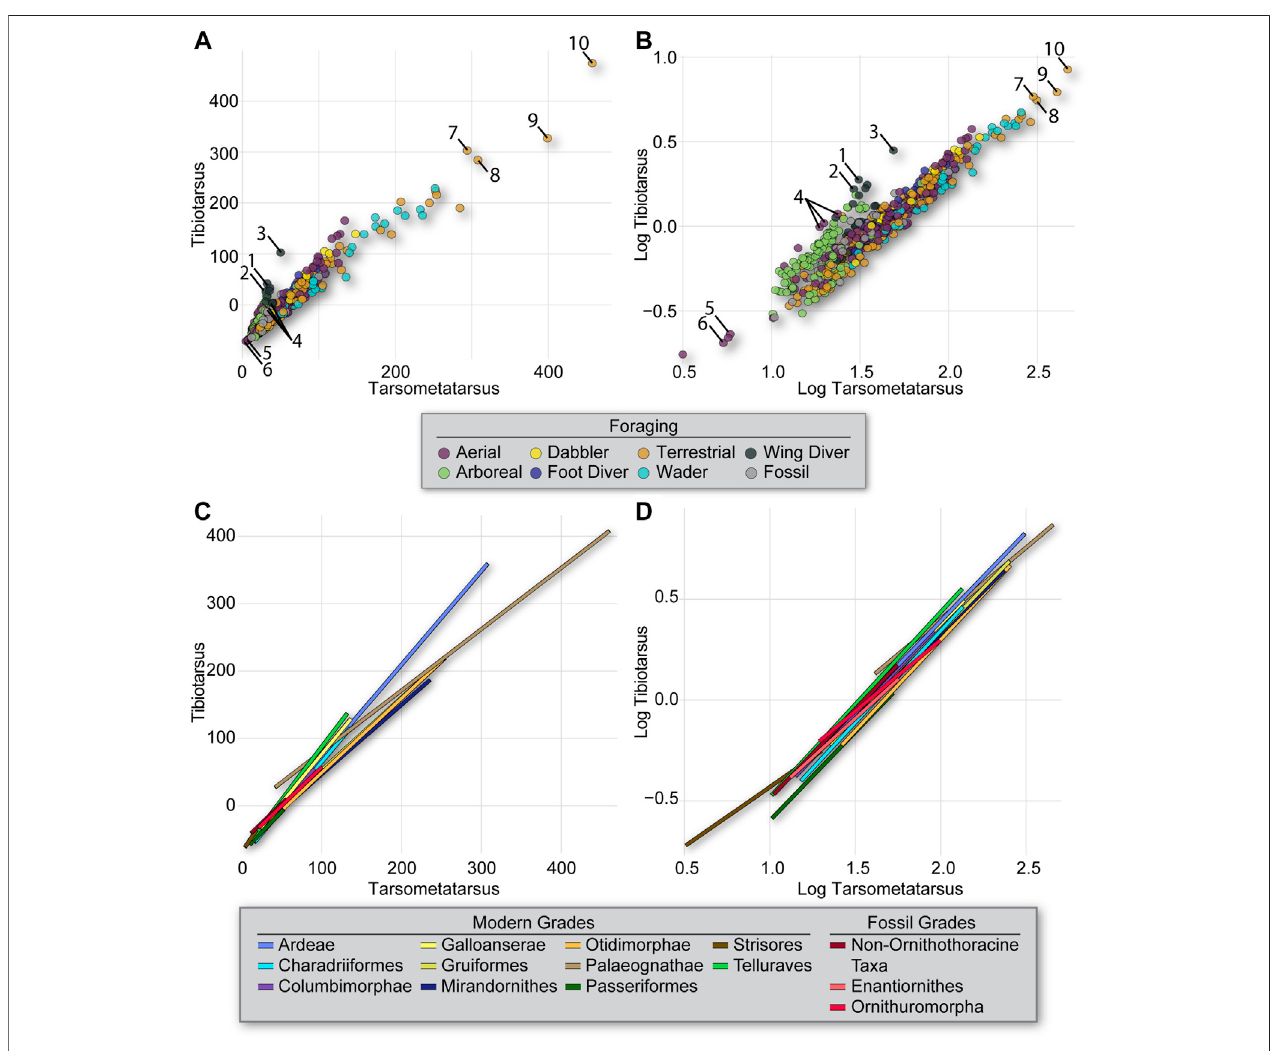
FIGURE 7 | Intralimb lower-leg proportions (tibiotarsus vs tarsometatarsus) from all specimens coded by foraging strategy (A,B) and slopes for phylogenetic groupings (C,D) resultingfromthePGLSregressionoftheuntransformed (A,C) andlog 10 -transformed (B,D) data.Asin Figure5 ,slopedifferencescollapsewhenusing log 10 -transformed data, confounding results. Taxa are numbered as follows in (A,B) : Penguins – 1 Pygoscelis, 2 Eudyptes , 3 Aptenodytes ; Frigatebird – 4 Fregata ; Hummingbirds – 5 Aphantochroa , 6 Archilochus ; Storks – 7 Leptoptilos, 8 Epihippiorhynchus ; Ratites – 9 Dromaius, 10 Struthio.